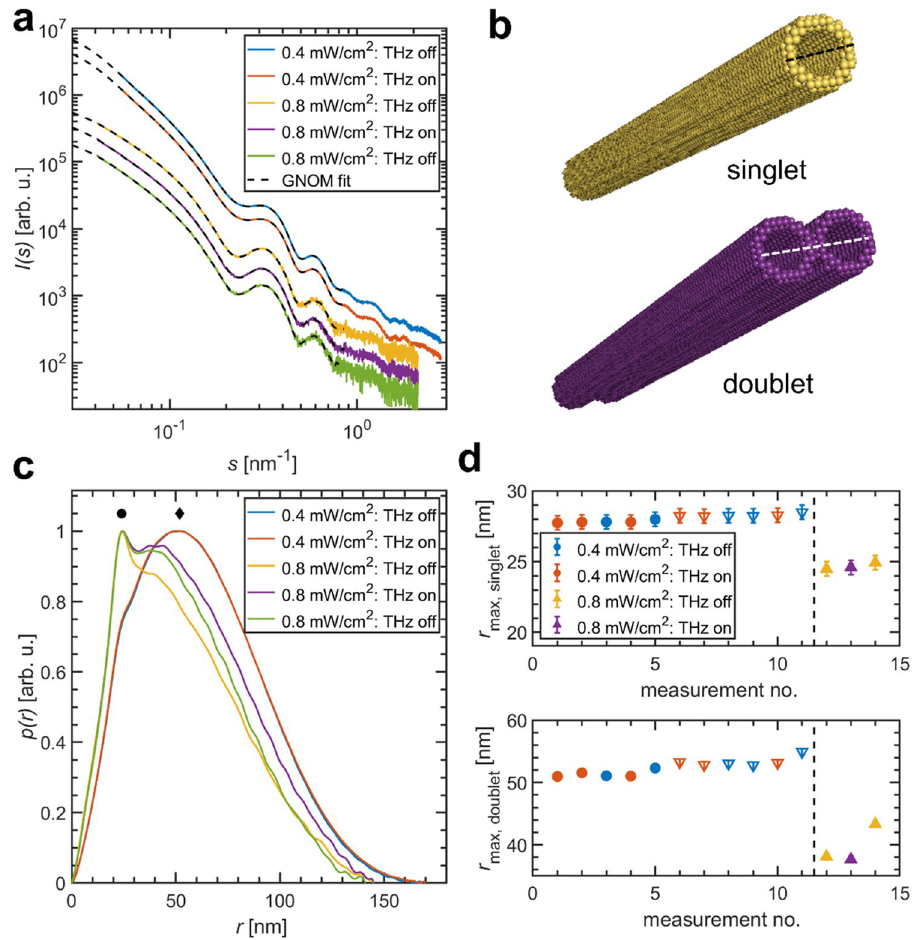
Figure 5. THz-SAXS measurements on microtubules. ( a ) SAXS profiles from exposed and non-exposed samples. Data have been collected in two independent beamtime sessions using different THz power densities. Dashed lines: GNOM fits. ( b ) Approximate structural models using dummy beads to compute the SAXS signal for singlet and doublets build using the ATSAS program BODIES (beads do not represent tubulin subunits). ( c ) Pair-distance distribution function p(r) computed from the SAXS curves displayed in ( a ) determined with GNOM. Characteristic features due to the structure of singlet and doublet are marked by a dot (singlet) and a diamond (doublet). ( d ) Effect of THz-exposure on the effective singlet and doublet diameter. The dashed line separates different sample preparation, e.g., different protein concentrations. Different symbols mark different MT